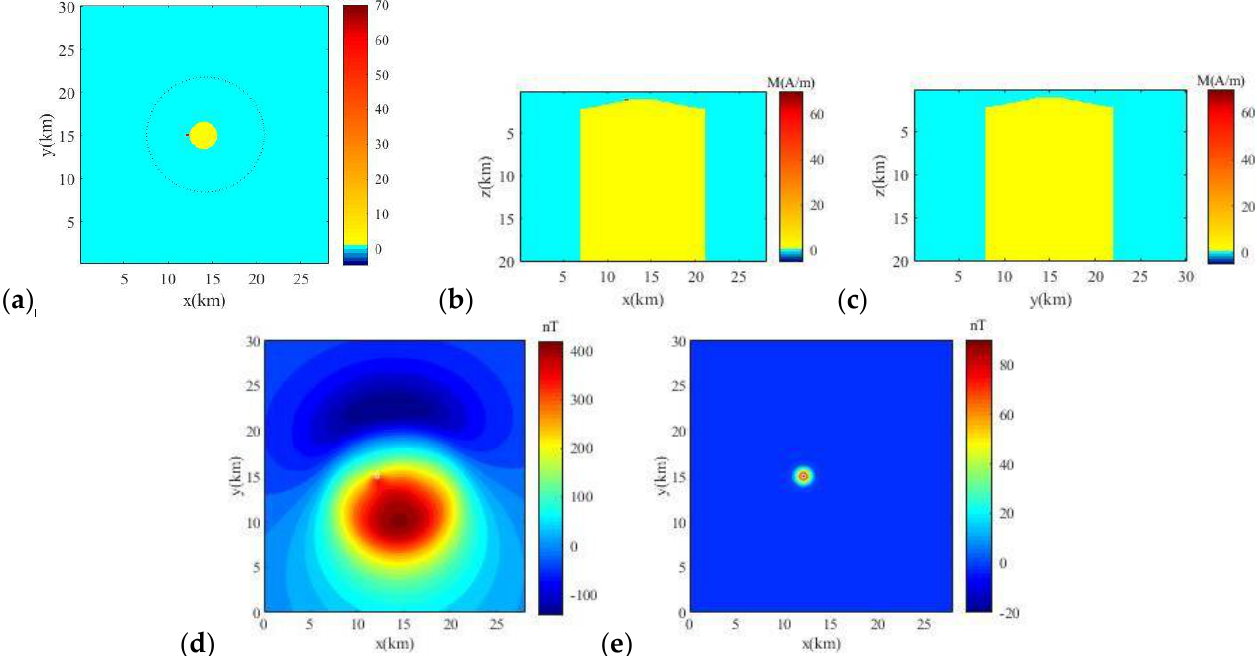
Figure 4. Theoretical model consisting of the mother rock (magnetization: 1 A/m) and the magnetite (magnetization: 60 A/m), and the magnetic anomalies at a flight height of 200 m obtained by forward calculation using this theoretical model: ( a ) a horizontal slice of the model at z = 1.1 km; ( b ) a vertical slice of the model at y = 15 km; ( c ) a vertical slice of the model at x = 14.1 km; ( d ) the total magnetic intensity ∆ T caused by the rock and magnetite; ( e ) the vertical magnetic anomalies in the case of vertical magnetization caused by the magnetite.